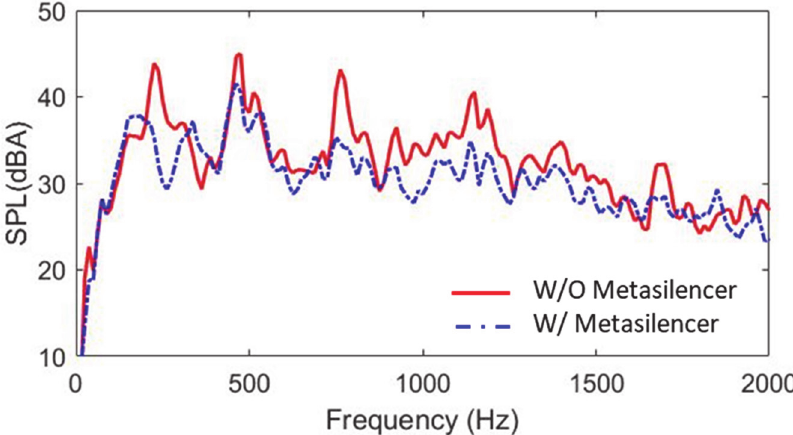
Figure 14. HVAC test results with 6 V applied.